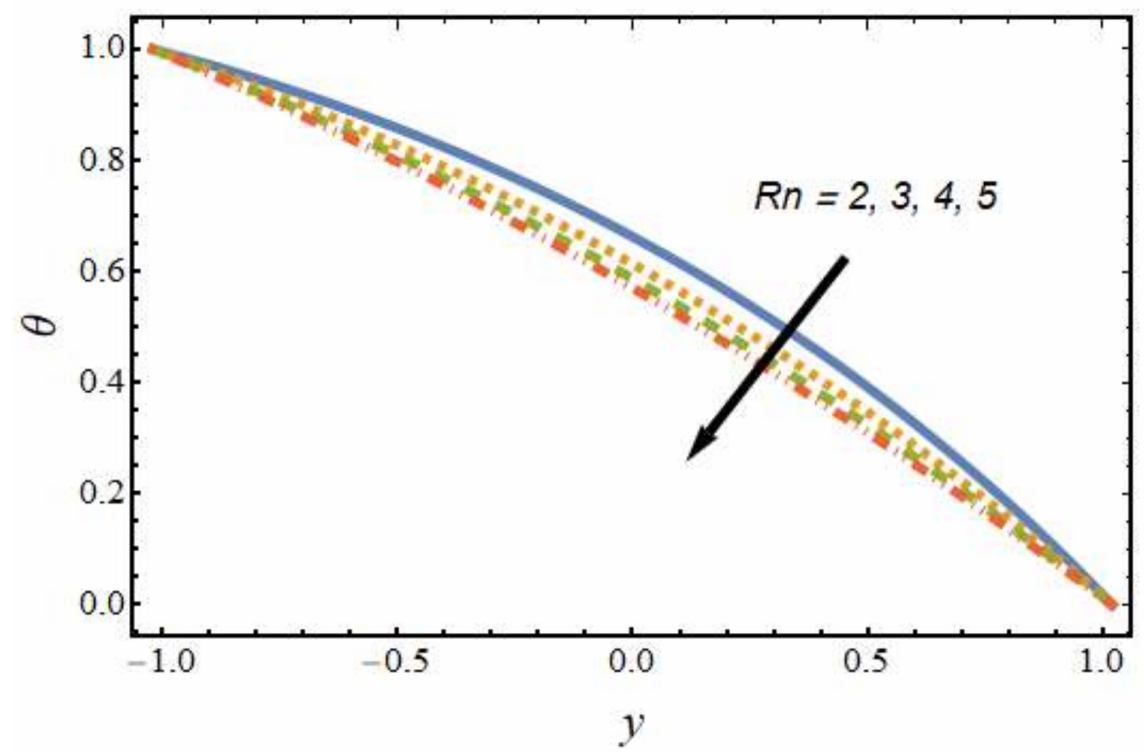
Figure 8. Nanoparticle temperature profile for various values of the radiation parameter.